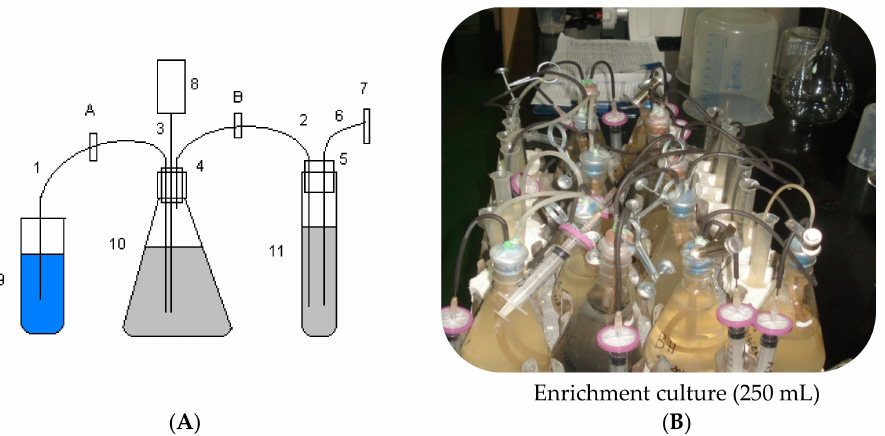
Figure 1. ( A ): 1: Liquid trap collector; 2: fresh medium flask collector; 3: syringe sample collector; 4: anaerobic plug; 5: flask bottom with air filter; 6 and 7: air filter; 8: syringe; 9: liquid flask; 10: Erlenmeyer culture flask; 11: medium flask. A and B: Filter 0.25 um. ( B ) Photo describing the denitrification